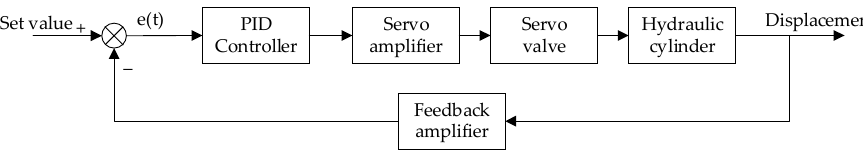
Figure 4. Hydraulic servo system PID control.